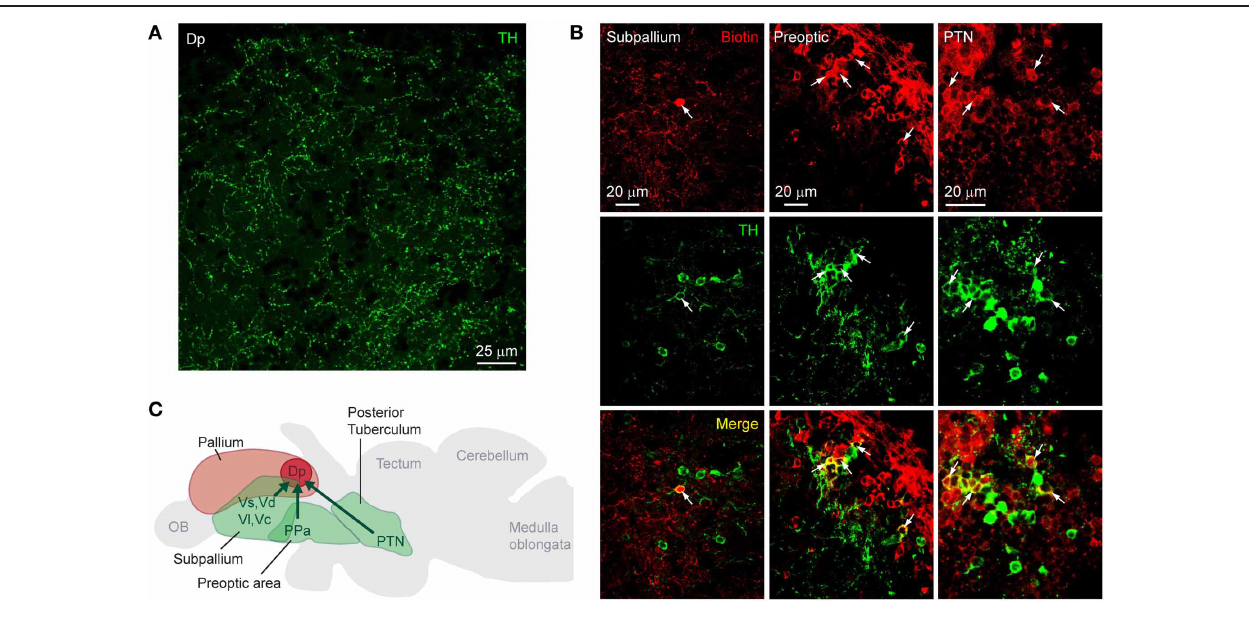
nucleus); confocal images]. Neurons double-positive for the tracer and TH (yellow) were found in all three brain areas. (C) Summary of results. TH-positive neurons that project to Dp were found in the subpallium, the preoptic area, and an area in the midbrain that appears to correspond to a nucleus in the posterior tuberculum (PTN).